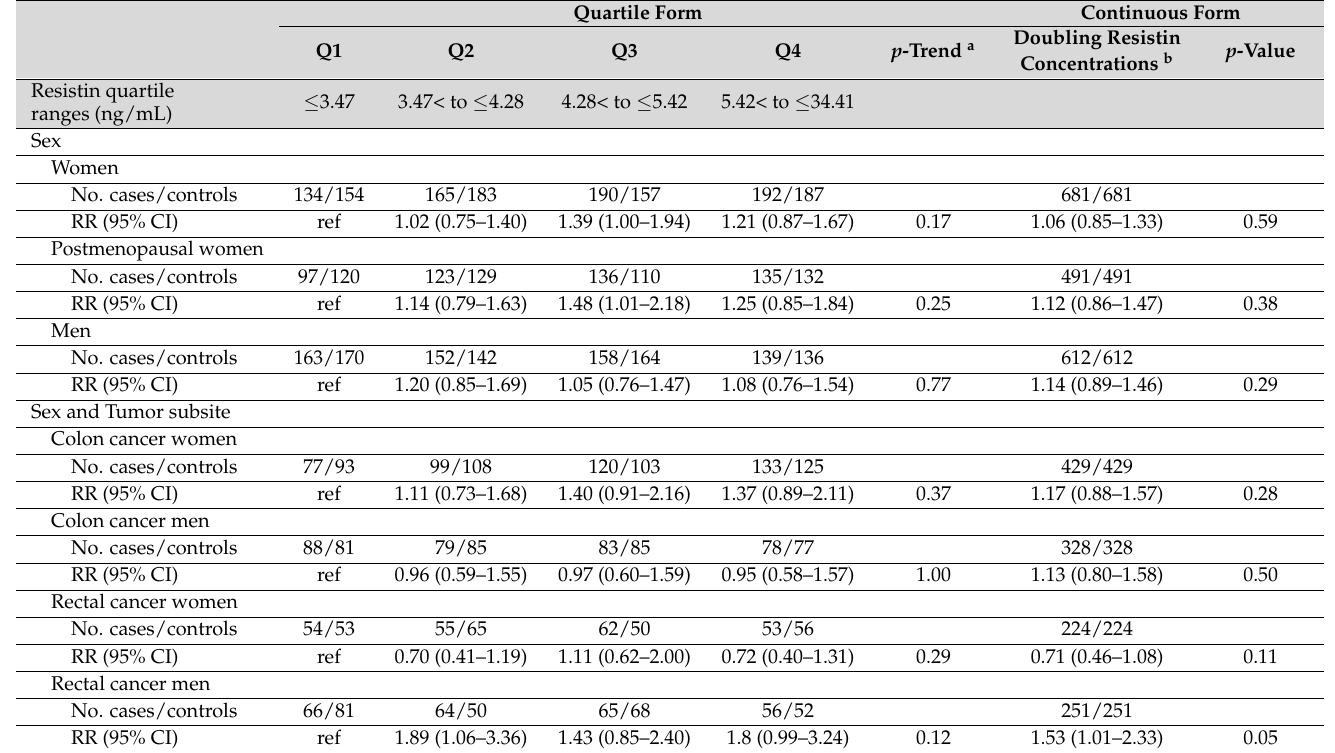
Table 4. Relative risk (RR) and 95% confidence interval (95% CI) estimated for the association between resistin concentrations and the risk of colorectal cancer stratified by sex and subsite in the EPIC study data (1992–2005) in conditional logistic regression models. Quartile Form Continuous Form Doubling p -Trend a